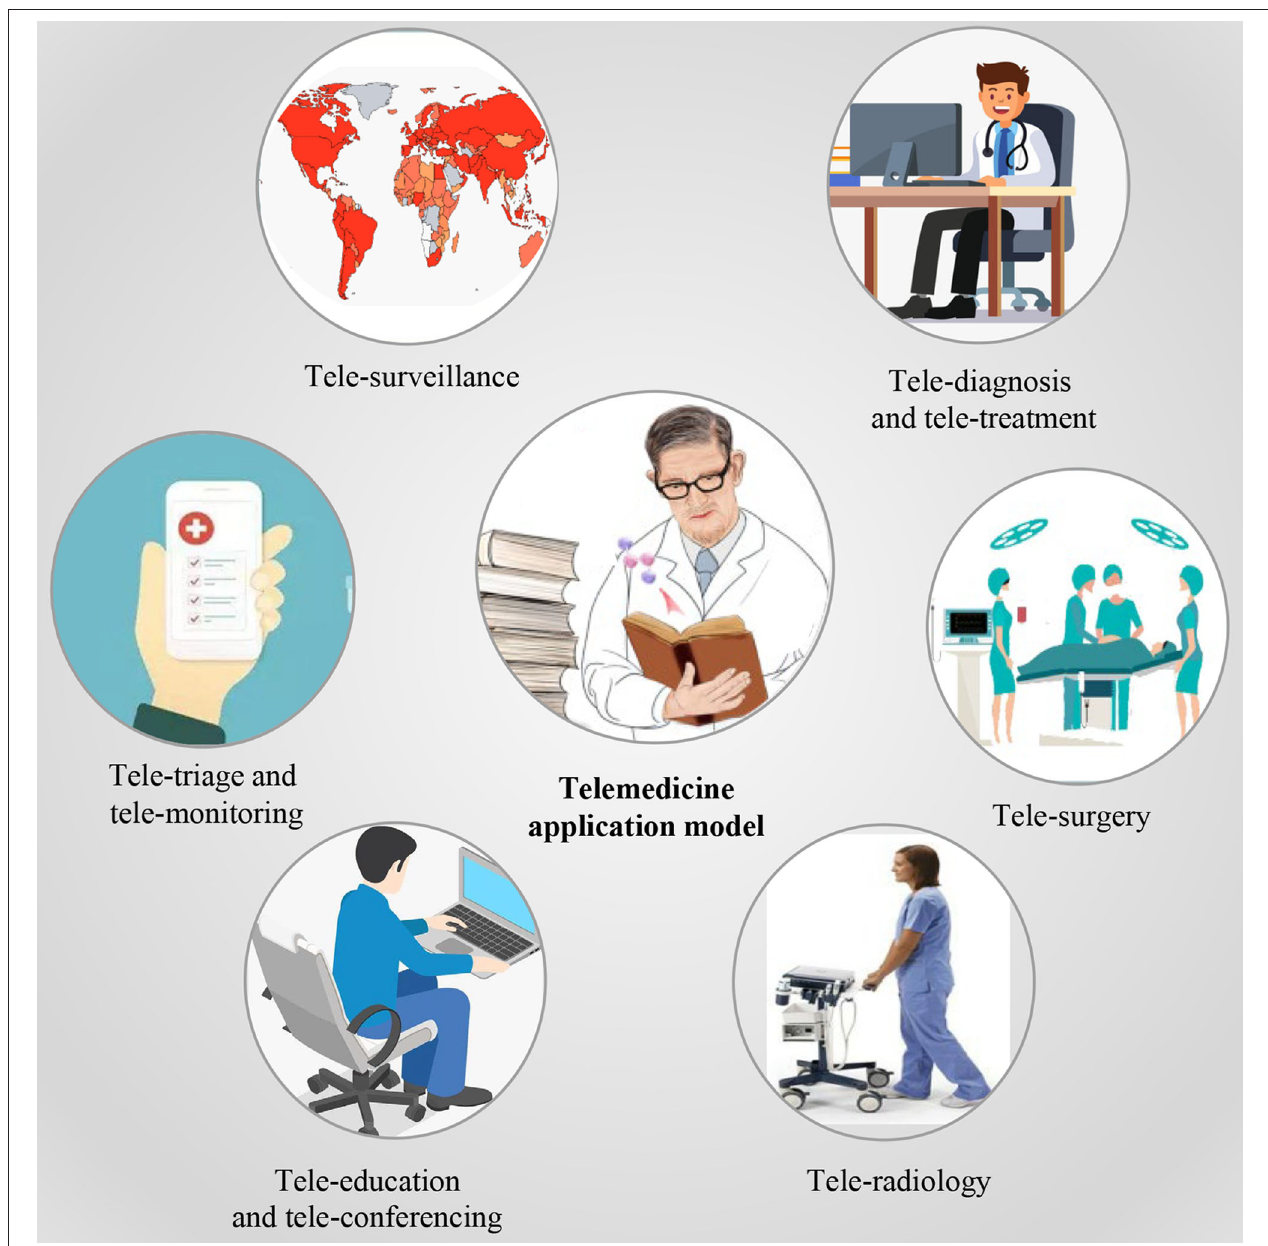
FIGURE 1 | Telemedicine application model in context of the coronavirus disease 2019